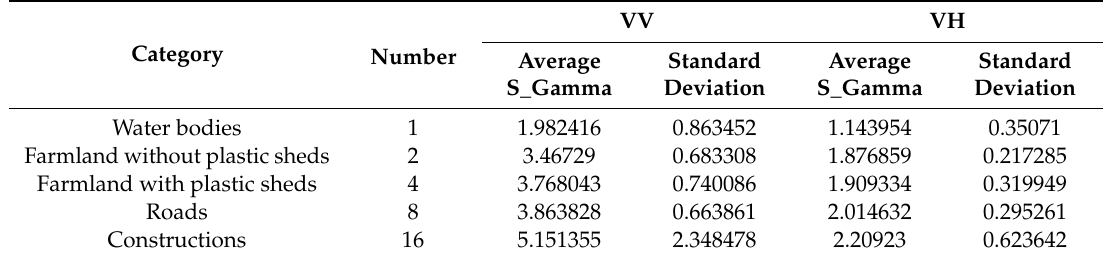
Table 4. Average S_Gamma and standard deviation of each